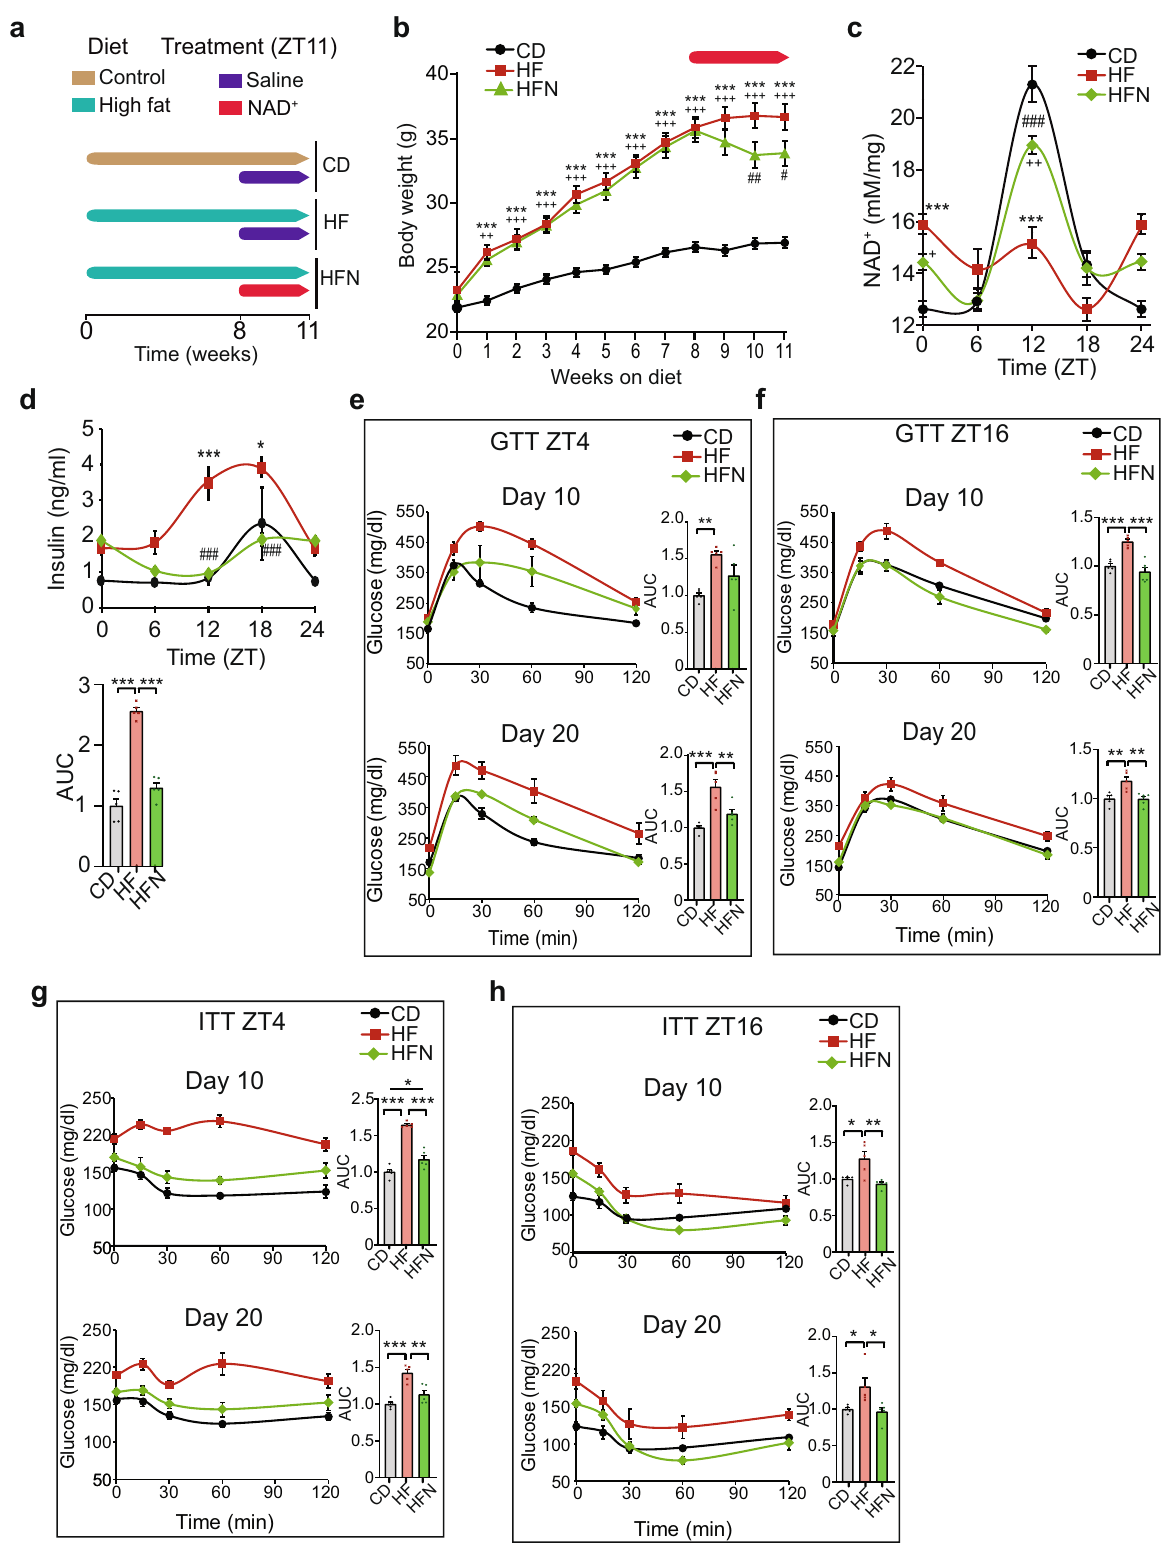
Remarkably, after 10 days, restoring NAD + oscillations in obese mice signi fi cantly ameliorated glucose tolerance, speci fi cally at ZT16 (Fig. 1e, f, AUC HF vs HFN at day 10: P <0.001, one-way ANOVA, Tukey post-test). After 20 days of treatment, this improvement was also apparentatZT4(Fig.1e,AUCHFvsHFNat day20: P =0.0084,one-way ANOVA,Tukeypost-test).Asbothinsulinandglucoselevelswerelower